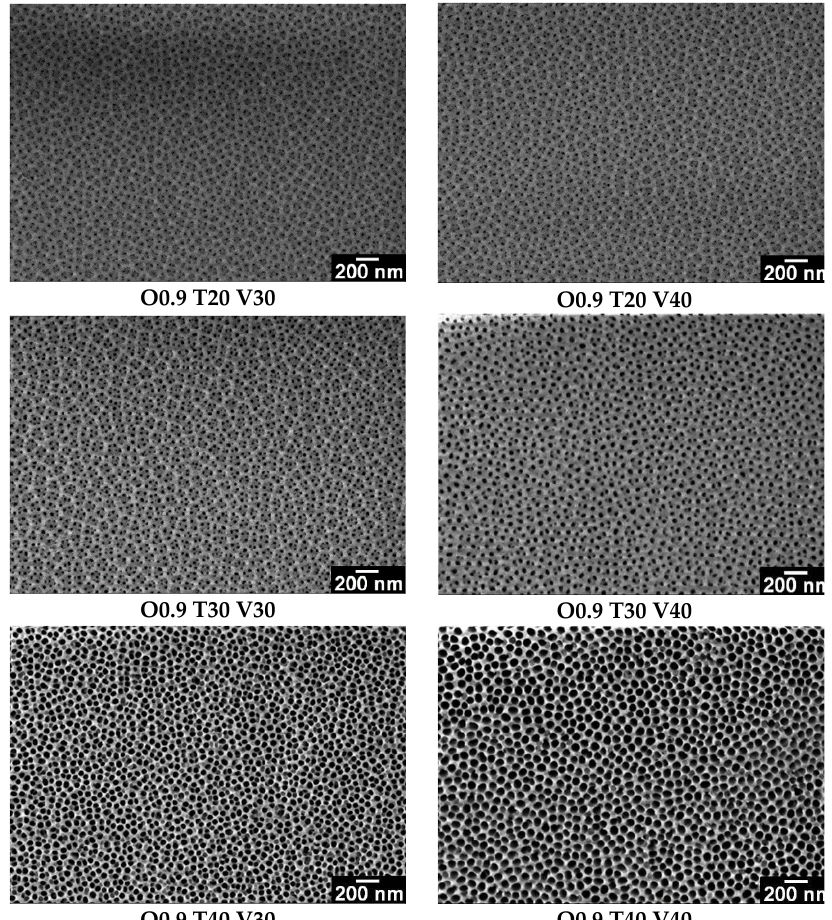
Figure 2. SEM images of nanostructured anodic aluminum oxide (AAO) films obtained by means of a one-step anodization process of 1 h in 0.3 M oxalic acid at different temperatures and voltages.